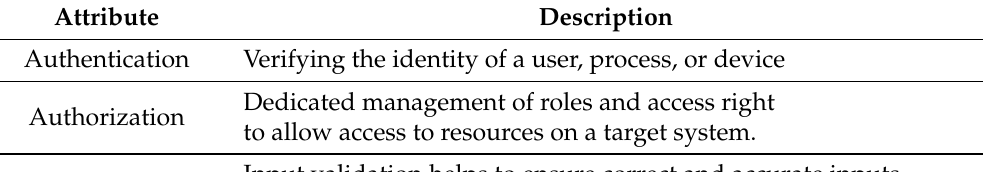
Table 2. An excerpt of the proposed security attributes for system components [29]. Attribute